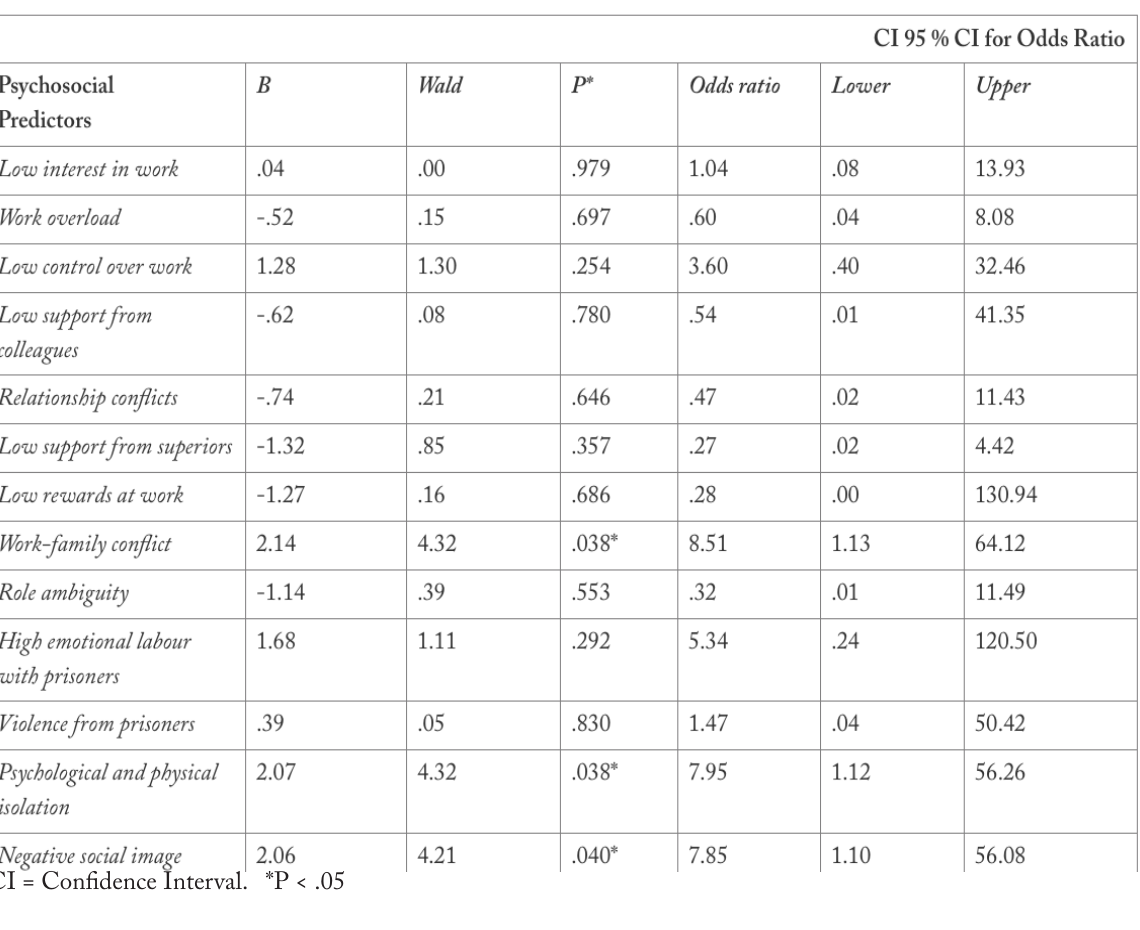
Table 5. Results of the logistic regression analysis with psychosocial parameters predicting cases of SBS among COs ( n = 76).